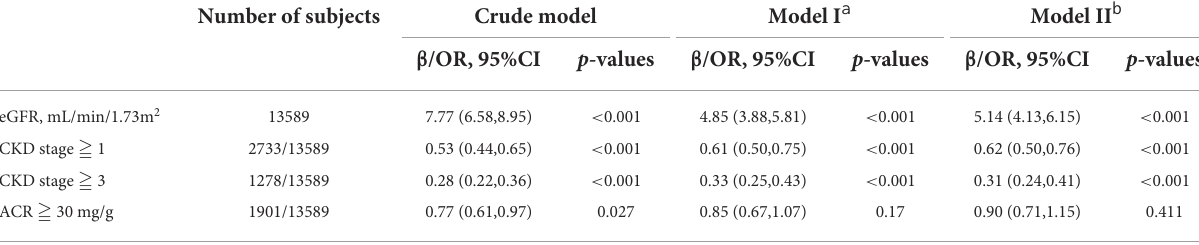
TABLE 2 Association between serum soluble Klotho and CKD.